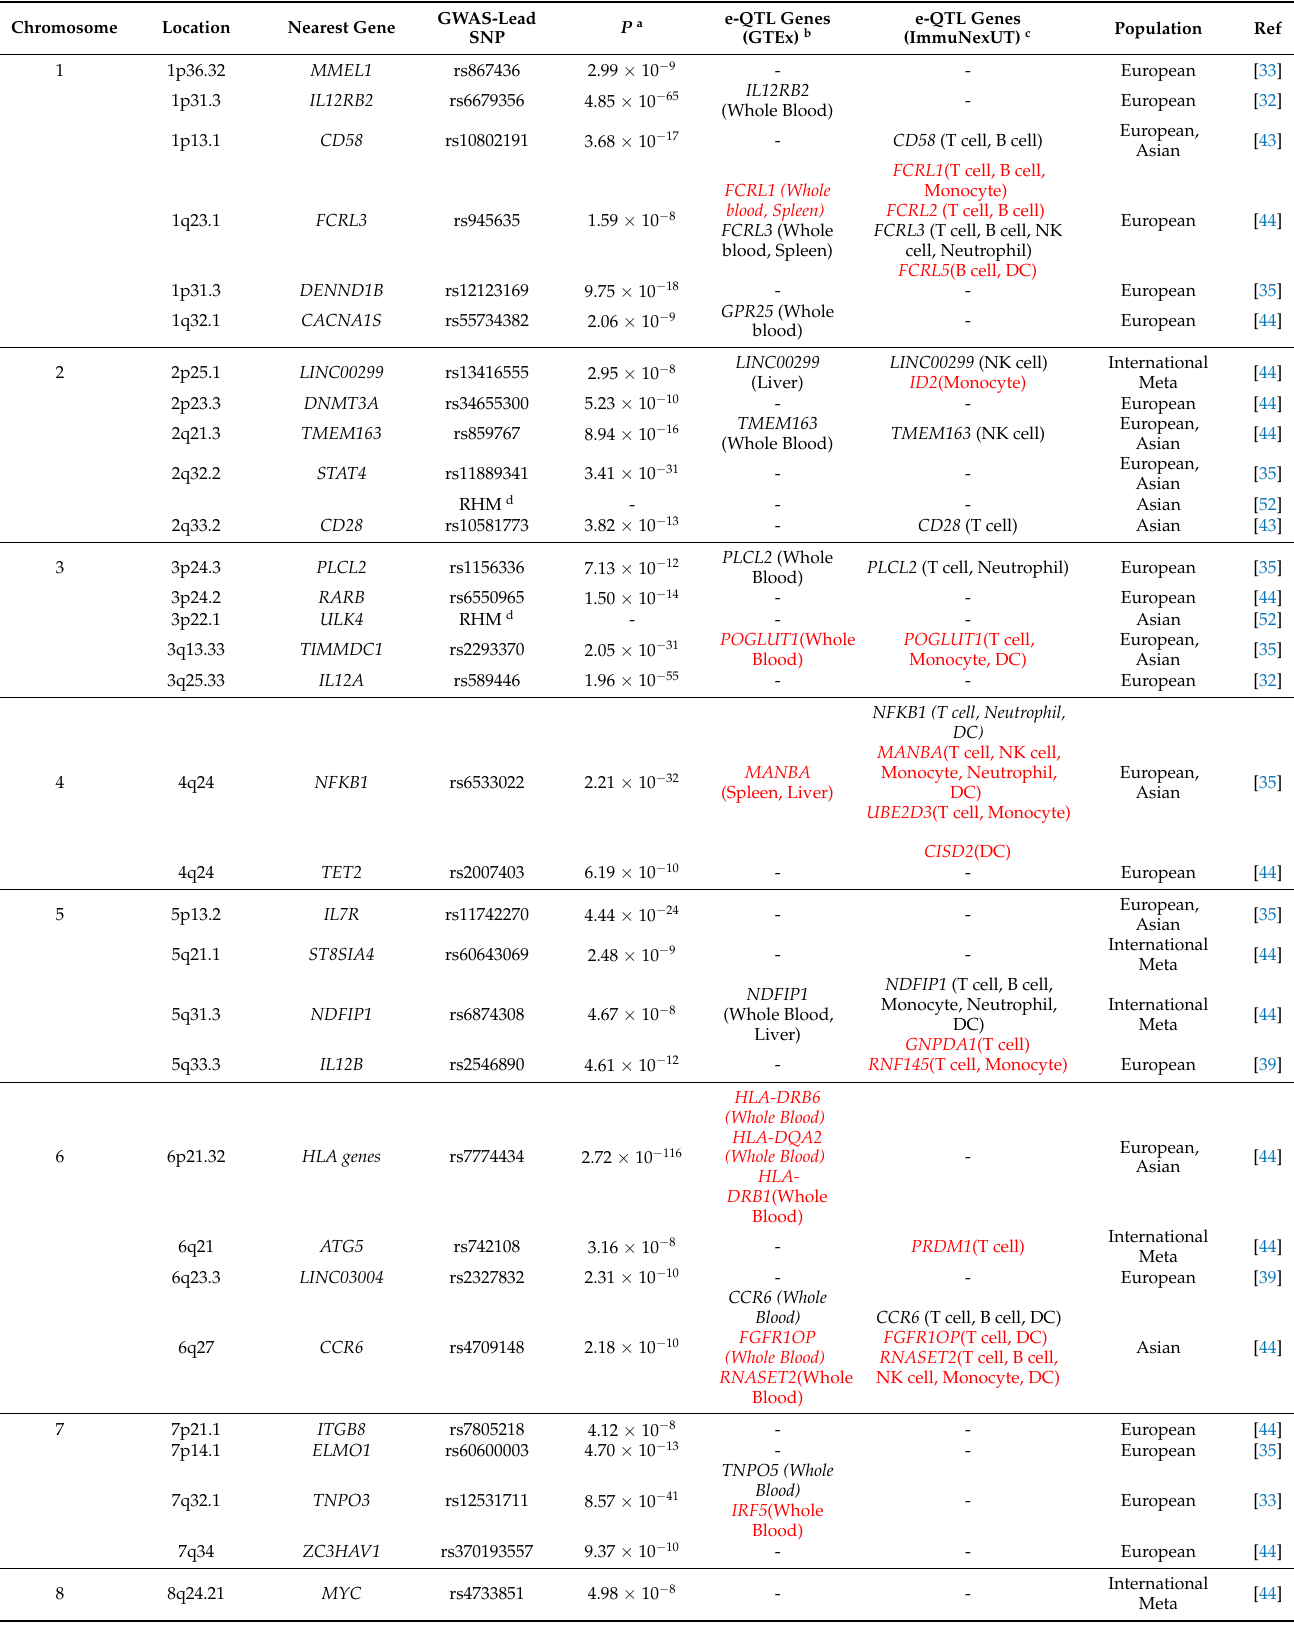
Table 1. PBC susceptibility loci and e-QTL